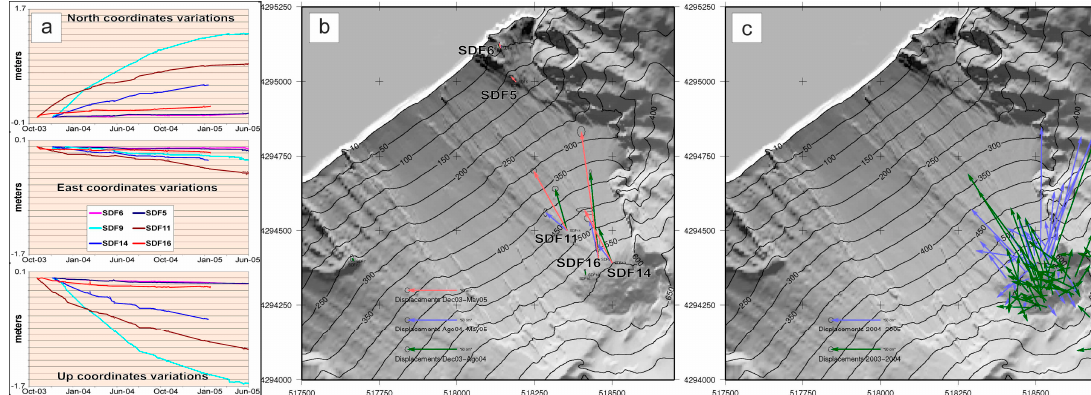
Figure 1. ( a ) Displacement time series recorded by THEODOROS system on the benchmarks; ( b ) Horizontal ground deformation registered by the THEODOROS monitoring system; red arrows for the entire 2003–2005 period, green arrows for the 2003–2004, and blue arrows for the 2004–2005 one; ( c ) Horizontal ground deformation measured by 3D single point measurement.